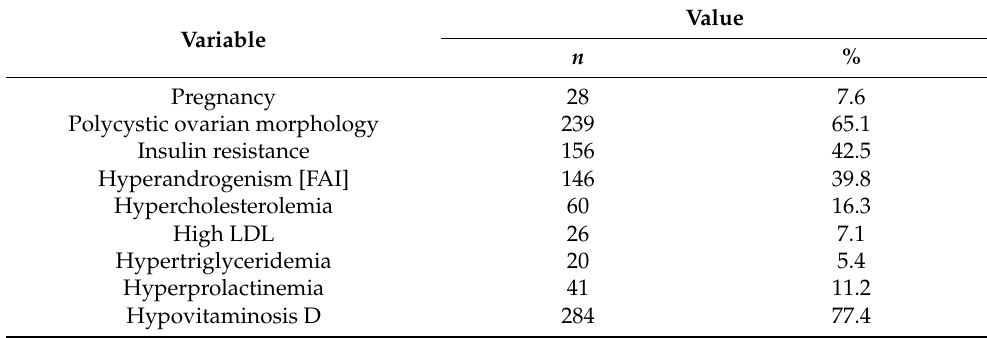
Table 2. Study population characteristics in relation to selected qualitative variables (N = 367).